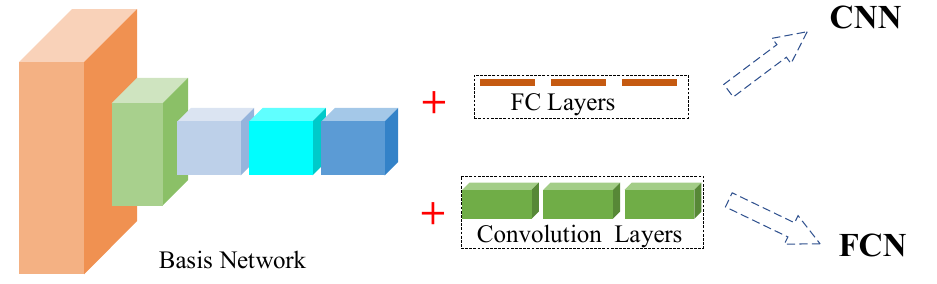
Figure 2. The difference between CNN and FCN.